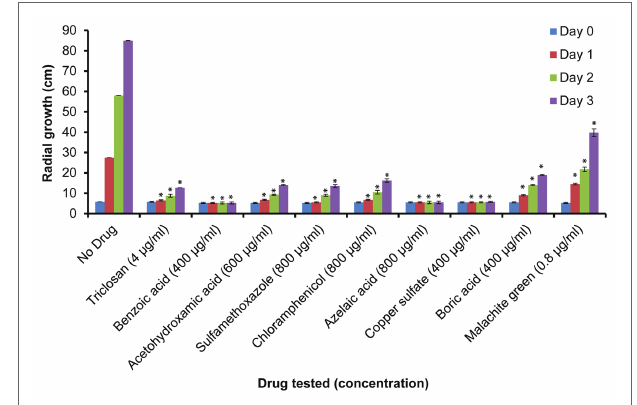
FIGURE 2 | Relative growth of S. parasitica on potato dextrose agar (PDA) plates. Growth of mycelium (measured as diameter in cm) in the presence of sub-inhibitory concentrations of the tested compounds after 0 (day 0), 24 (day 1), 48 (day 2), and 72 h (day 3) of culture at 24 ° C. Four independent replicates were measured for each drug. A Student’s t -test was also performed to check significant differences between drug treated samples compared to the sample without drug ( * p <